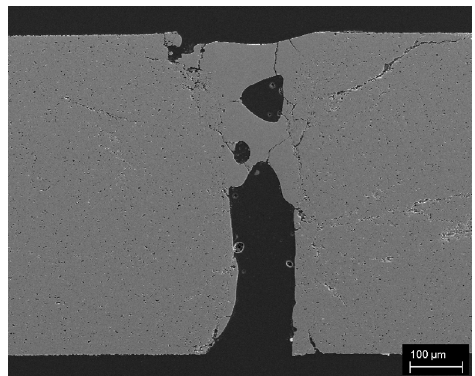
Fig. 4 Weibull probability grid plot of dielectric strength (AC) of 380 µm Al 2 O 3 for different voltage ramp